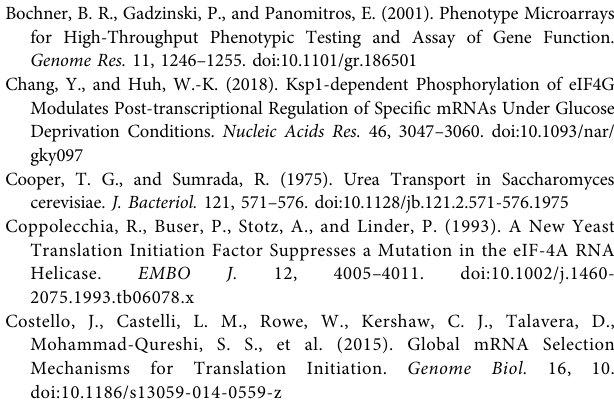
( Supplementary Figure S5 ) and eIF4B NTD-independent gene ontology ( Supplementary Tables S7, S8 ). In some conditions it is likely that derepression of strong closed-loop mRNAs that promote growth could be equally or more detrimental to cells as not producing membrane associated proteins needed for a particular stress response. An analogous scenario has been described for eIF4G-phosphorylation-mediated control of mRNAs in response to glucose starvation in yeast (Chang and Huh,